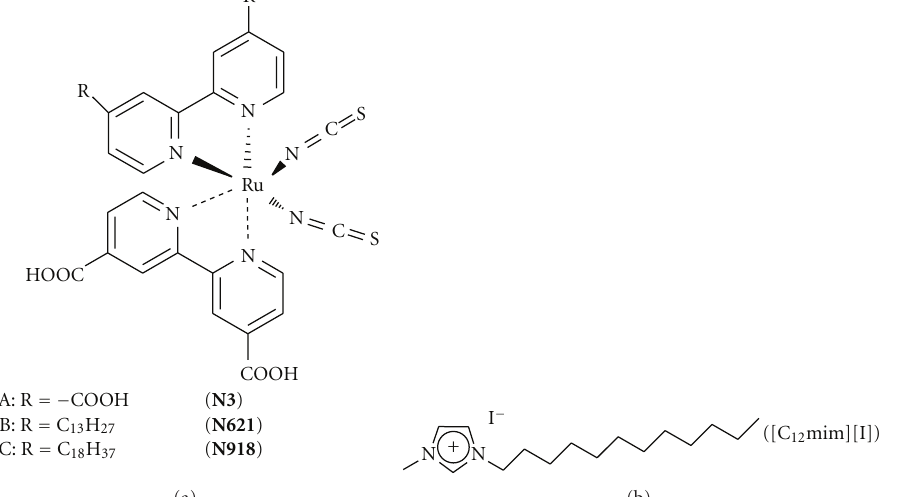
Figure 16: Molecular structures of (a) ruthenium dyes (A: N3 , B: N621 , and C: N918 ), and (b) an ionic liquid crystal ([C 12 mim][I]) (taken from [33]).